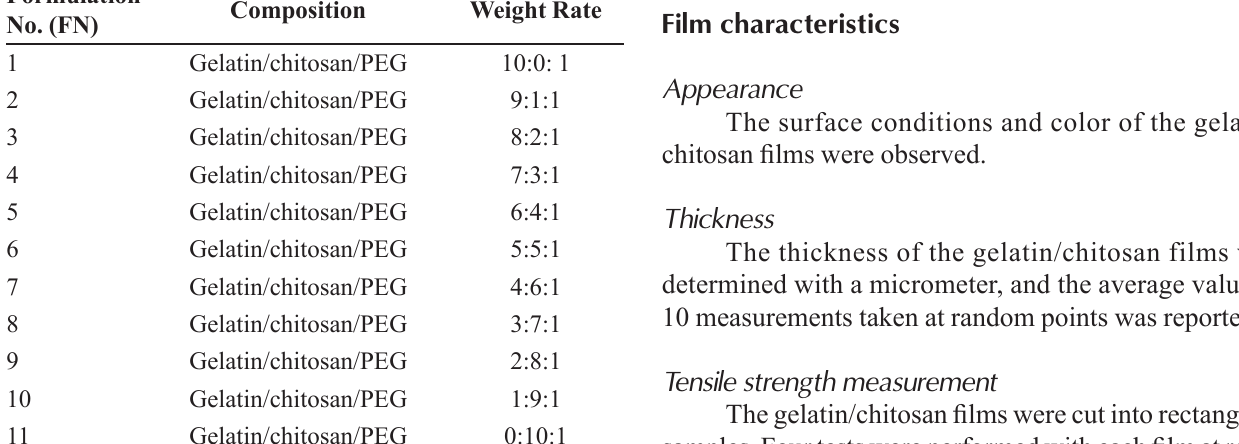
TABLE I - Formulation design of film